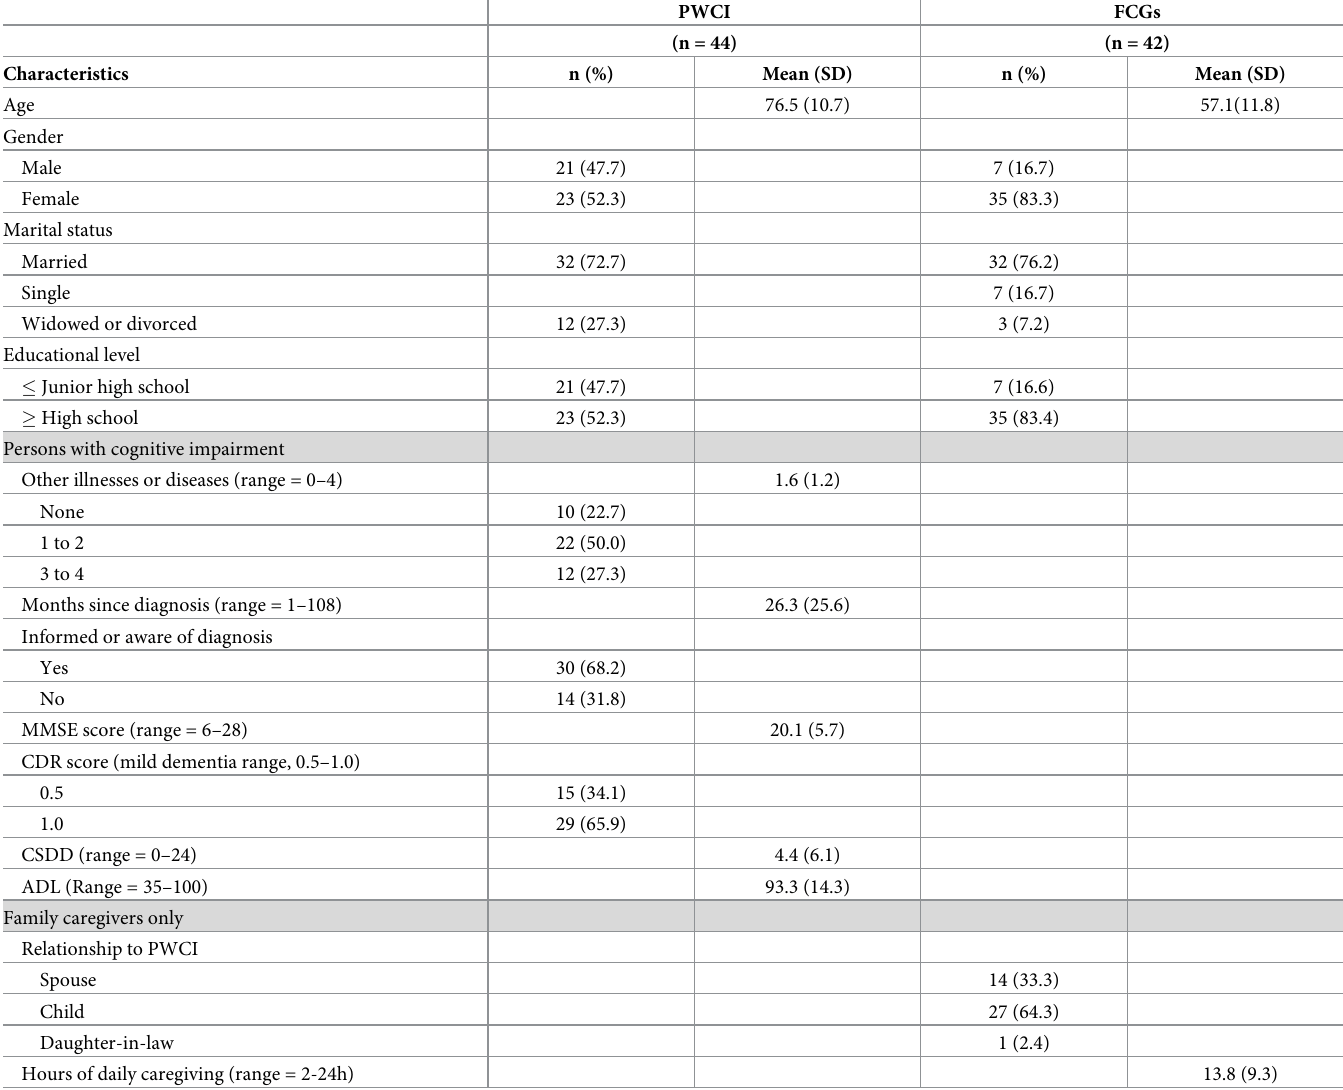
Table 1. Sociodemographic characteristics of persons with cognitive impairment (PWCIs) and family caregivers